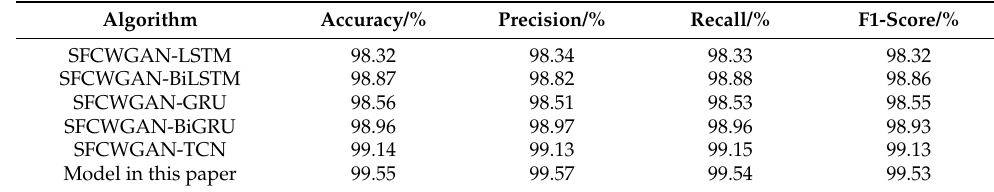
Table 9. Detection accuracy under the influence of difference algorithms on Kaggle dataset.